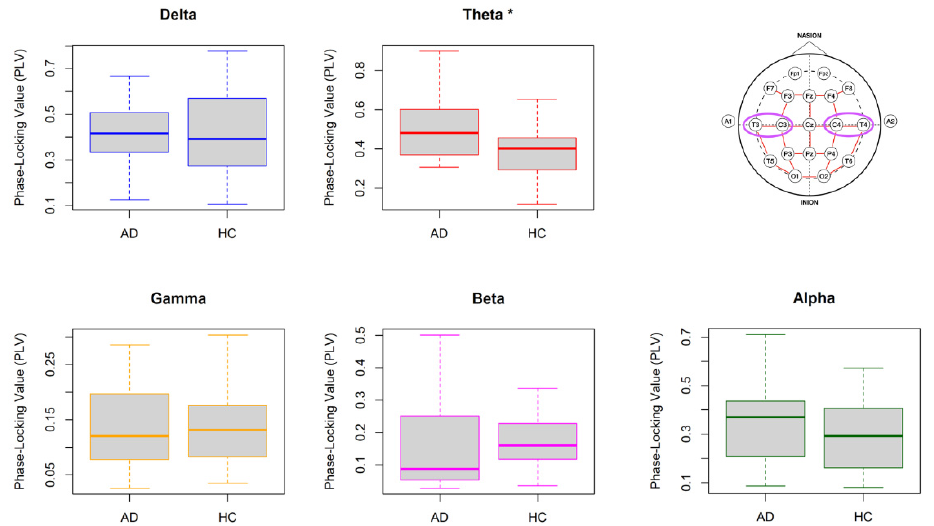
Figure 7. The PLVs obtained from the homotopic pair in the centro-temporal region (Pair D). Plots marked with * indicate a statistically significant difference ( p < 0.05) between AD patients and HCs. Summing up, the comparison of PLV in the selected homotopic pairs resulted in observing the main differences in the low frequency bands of delta and theta.